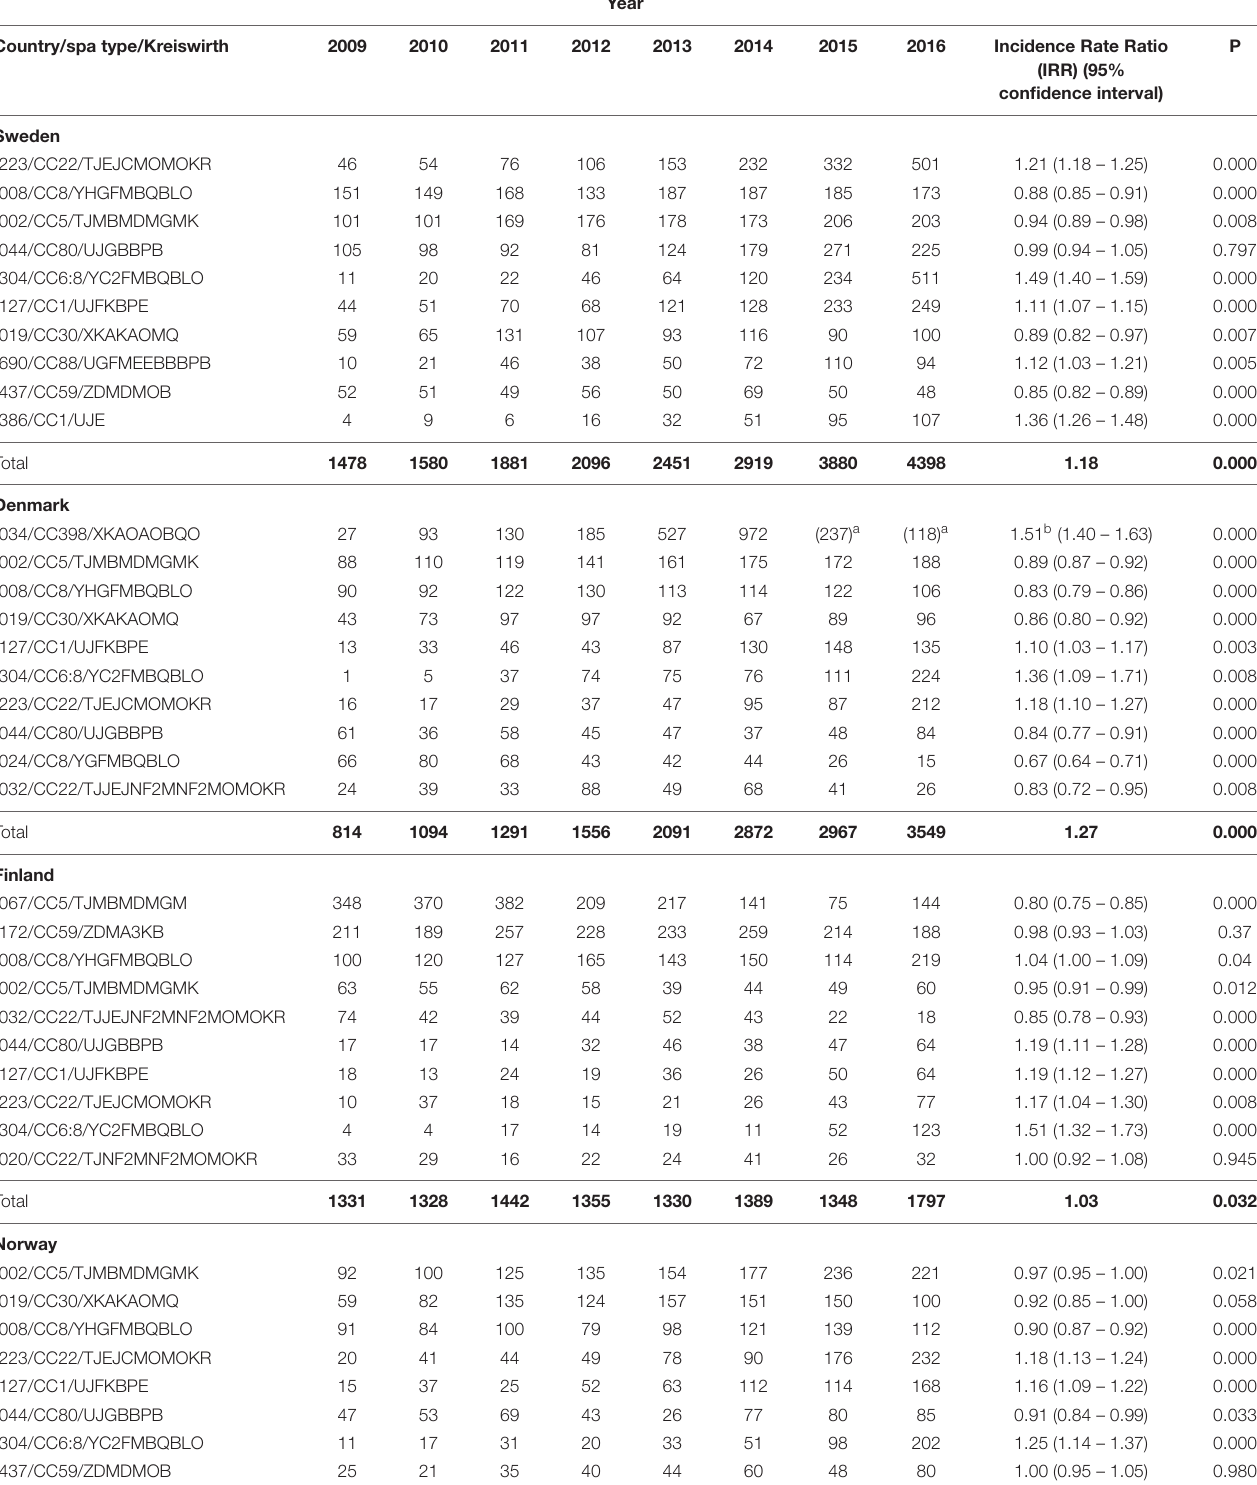
TABLE 3 | Numbers and trends of the ten most prevalent spa types among MRSA cases in the Nordic countries in 2009–2016. Total denotes total number of MRSA per year and trend of total